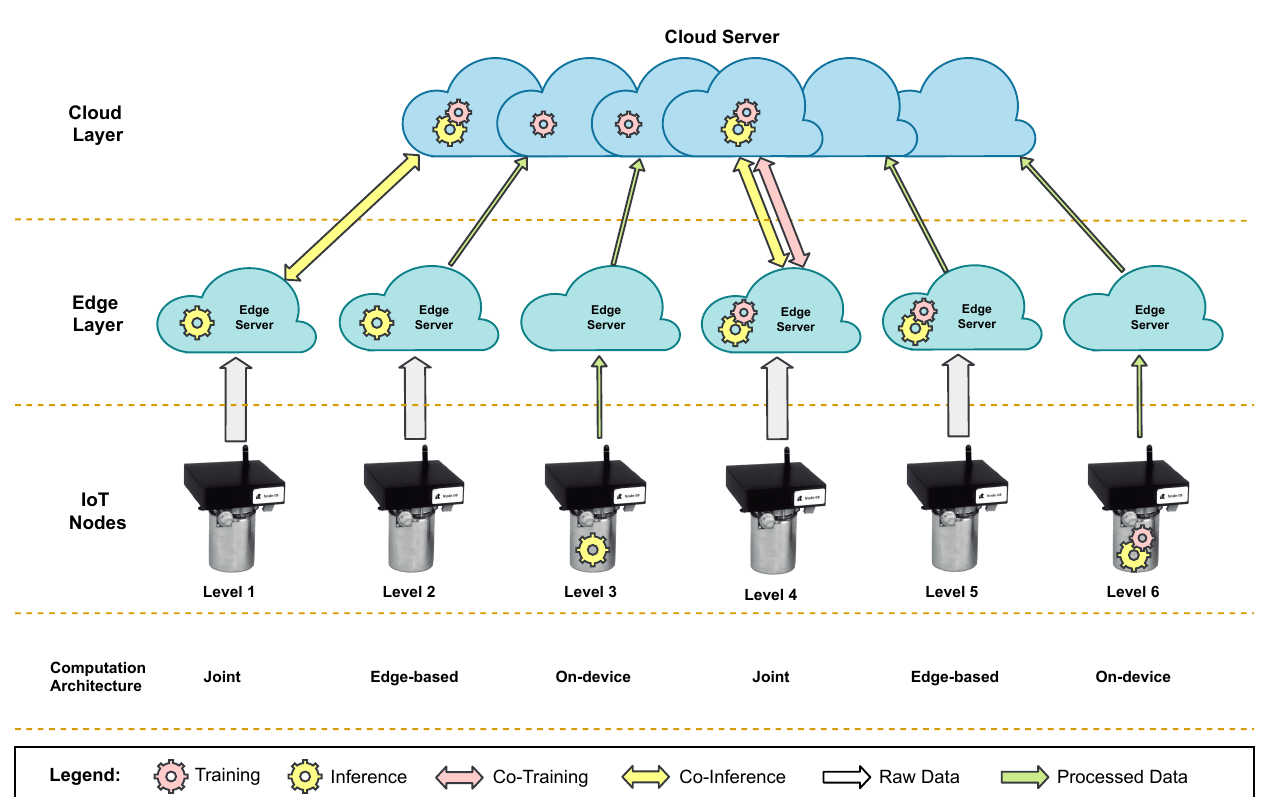
Figure 5. Edge-AI Levels and model inference computation architectures: on-device, edge-based, and